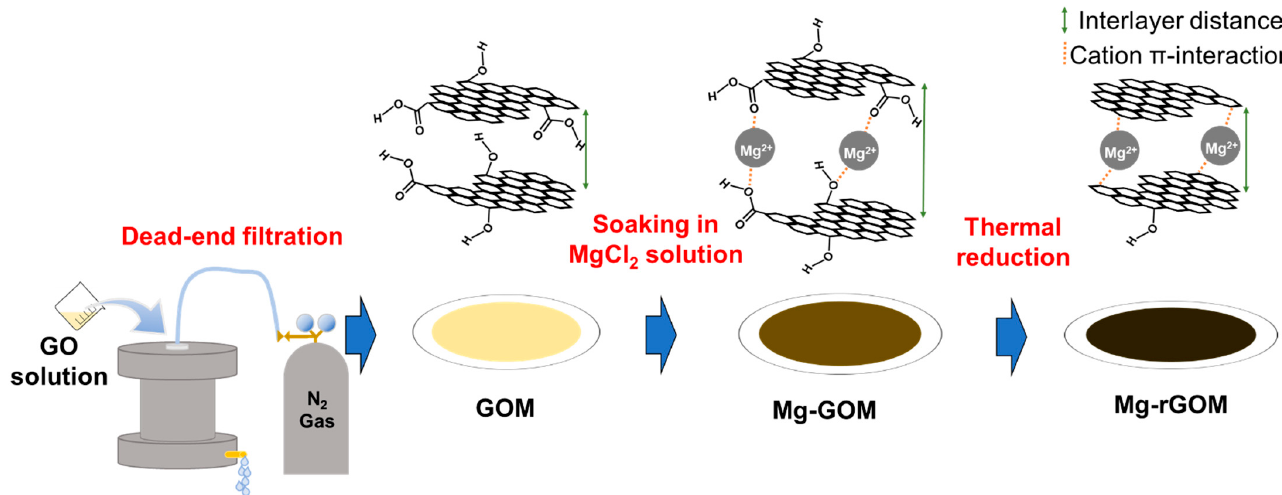
Figure 1. Illustration of the fabrication of the GOM series.